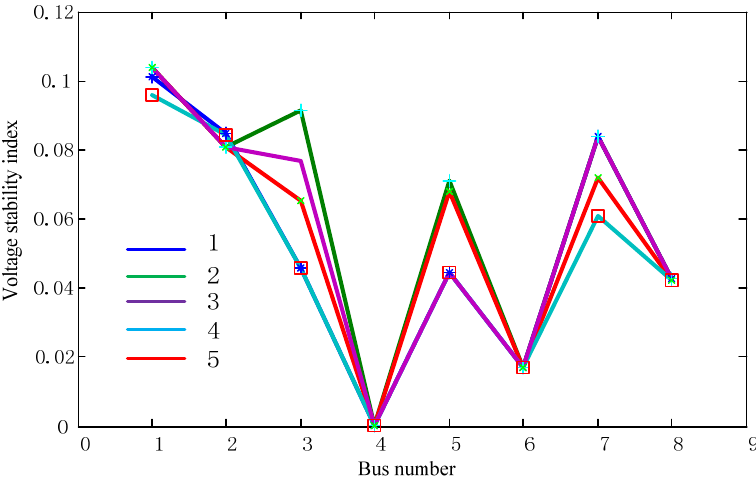
Figure 13. Voltage stability index performance of five schemes.